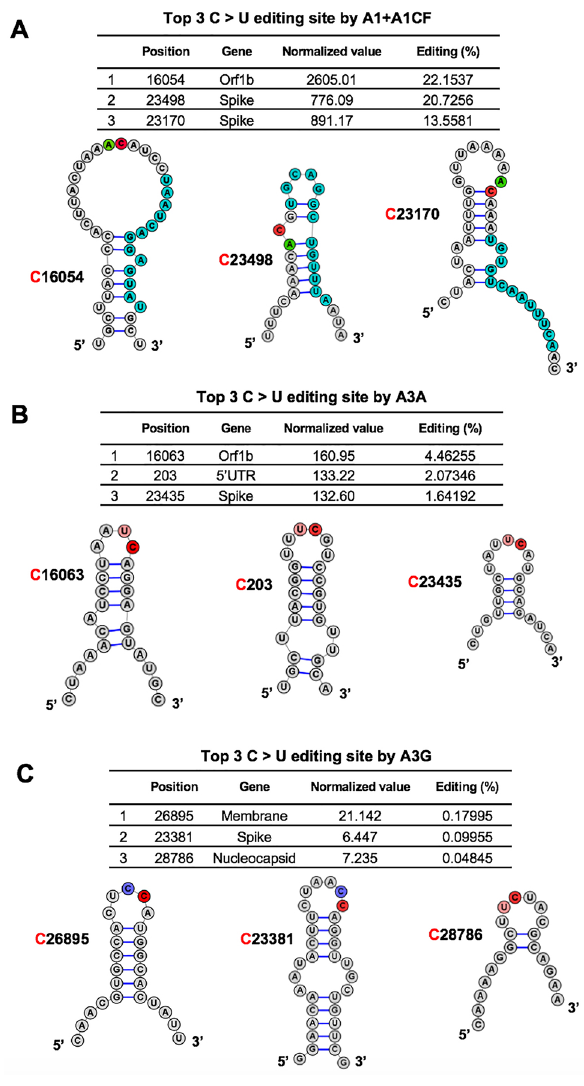
Figure 3. Overall features of the RNA around the most preferred APOBEC-edited sites on SARS-CoV-2. The predicted RNA secondary structures 62 of the sequences near the top 3 highest editing C sites by A1 + A1CF ( A ), A3A ( B ), and A3G ( C ) (see related Supplementary Dataset File 2). The editing efficiency of each site is listed at the top of each panel. In the secondary structure, the target C sites are highlighted in red, and -1 positions of the target C sites are highlighted in green for A, pink for U, and blue for C, respectively. In panel ( A ), the proposed canonical mooring sequences for A1 + A1CF (highlighted in sky blue) contain relatively high U/A/G contents downstream of the target